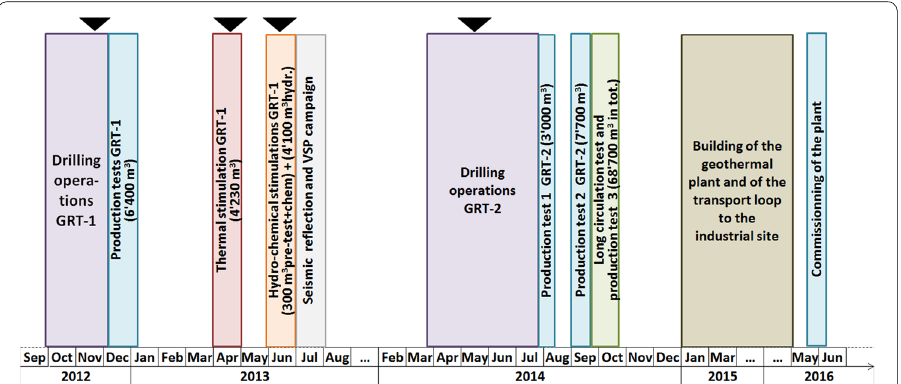
Fig. 3 Timeline of the operations performed during the development of the Rittershoffen deep geothermal field. The seismogenic periods of interest (during GRT-1 drilling, thermal and hydraulic stimulations and GRT-2 drilling) are indicated by black